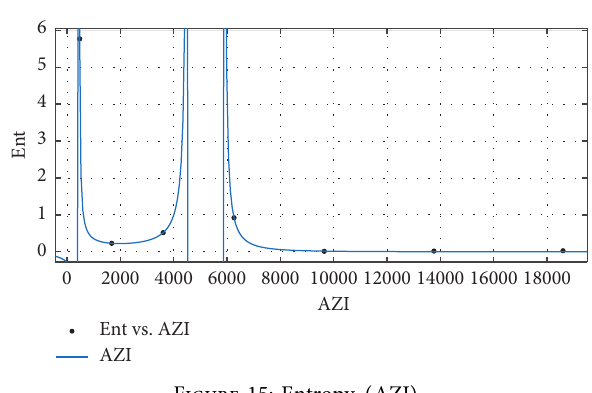
Figure 15: Entropy ( AZI ) .